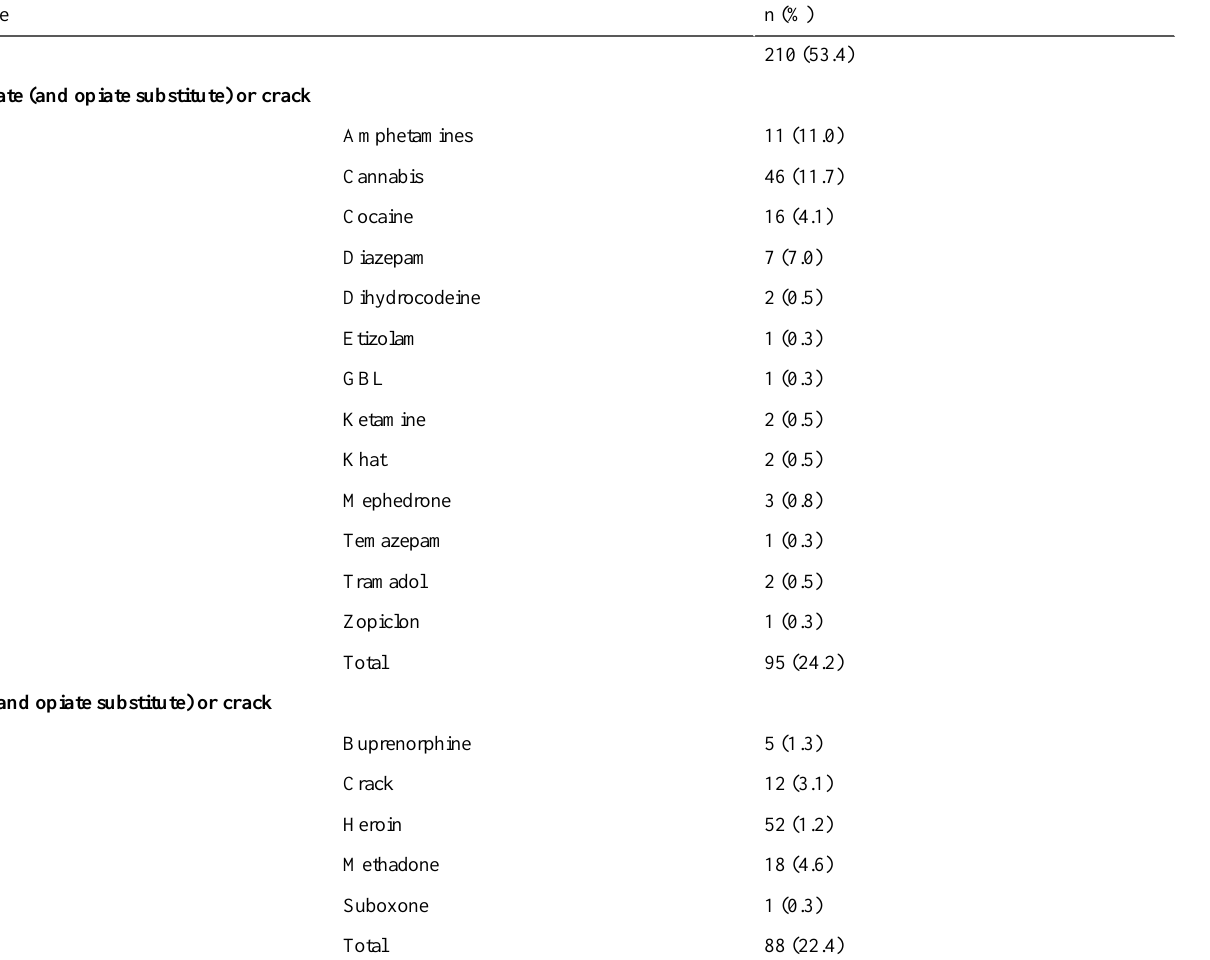
Table 1. The main substances of dependence